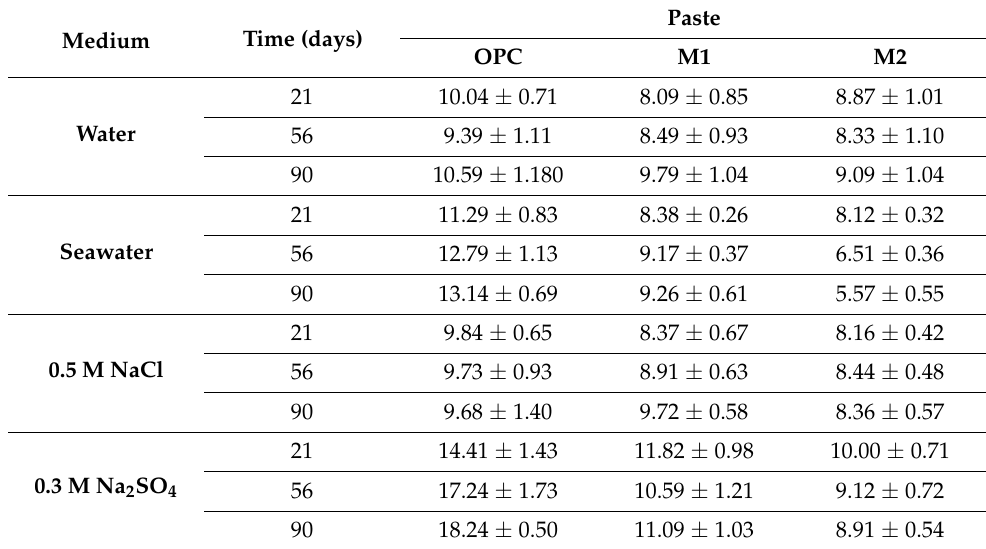
Table 3. Flexural strength (MPa) of pastes soaked in water or aggressive